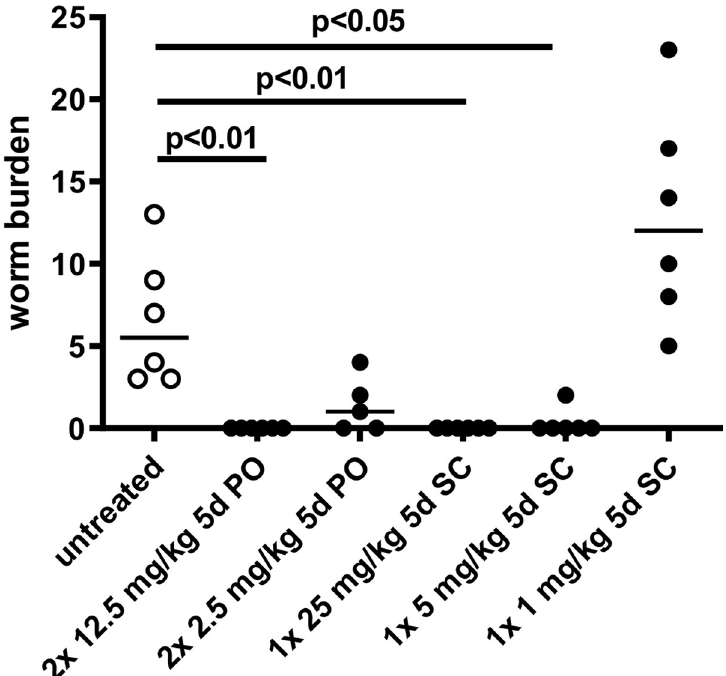
Fig 4. Comparison of the macrofilaricidal efficacy of oral and subcutaneous treatment routes for oxfendazole. L . sigmodontis adult worm burden 78 dpi in mice naturally infected with L . sigmodontis and treated for five consecutive days (5d) with oxfendazole twice per day orally (PO) with 2.5 (n = 5) or 12.5 mg/kg body weight (n = 6) and once per day subcutaneously (SC) (n = 6 per group) with 1, 5 or 25 mg/kg oxfendazole. Untreated controls (n = 6) received no oral or subcutaneous treatments. Medians of a single experiment are shown. Kruskal-Wallis H-test: χ 2 = 29.26, df = 5, p < 0.0001 followed by Dunn’s multiple comparison